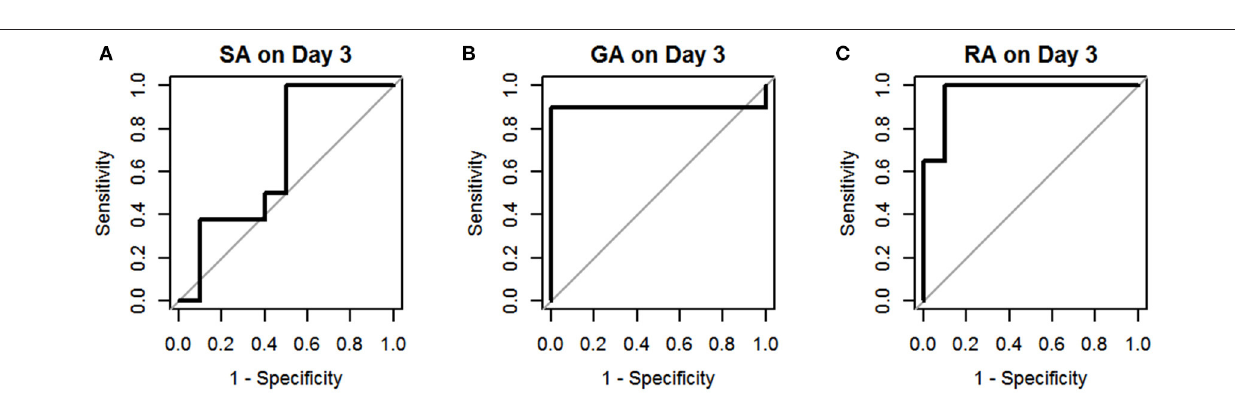
SA on day 2, GA on days 2–3, and GA on days 1 to 3, as shown